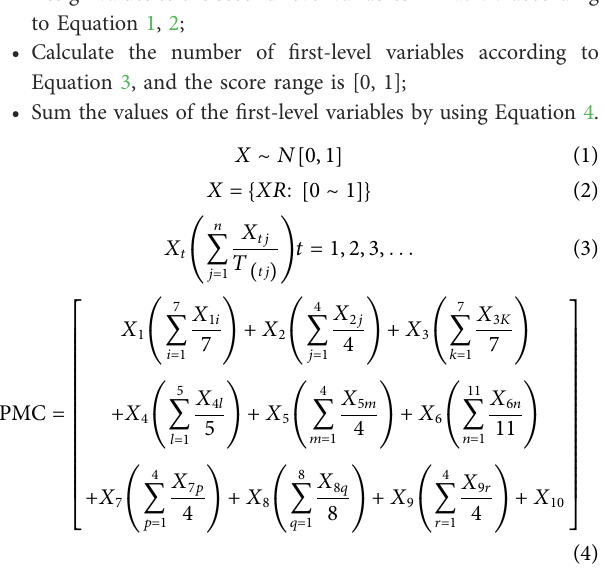
evaluation results. Based on Estrada ’ s classic PMC index model